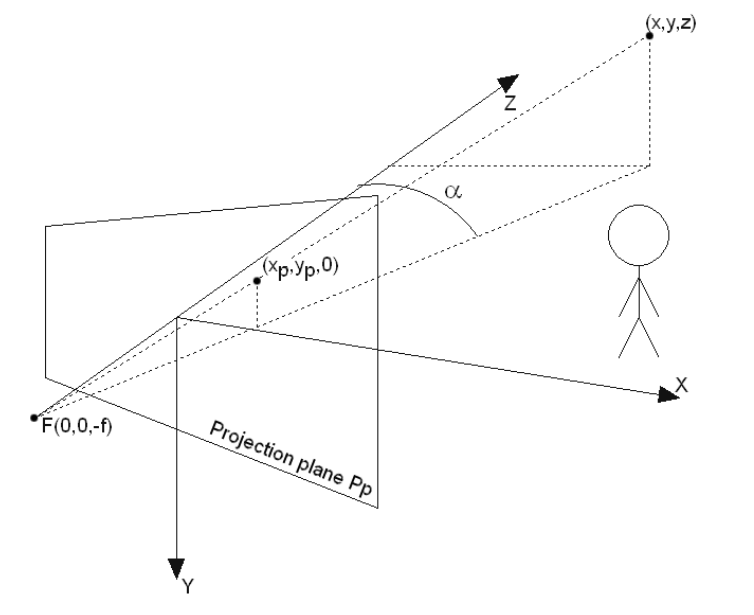
Figure 9. The local coordinate system of the stereovision camera. F is the focus of the camera, and f is the focal length, ( x, y, z ) are the coordinates of a point in the camera coordinate system. This point has the coordinates ( x the camera and α denotes the angle from the Z axis at which point ( x, y, z ) is visible by the